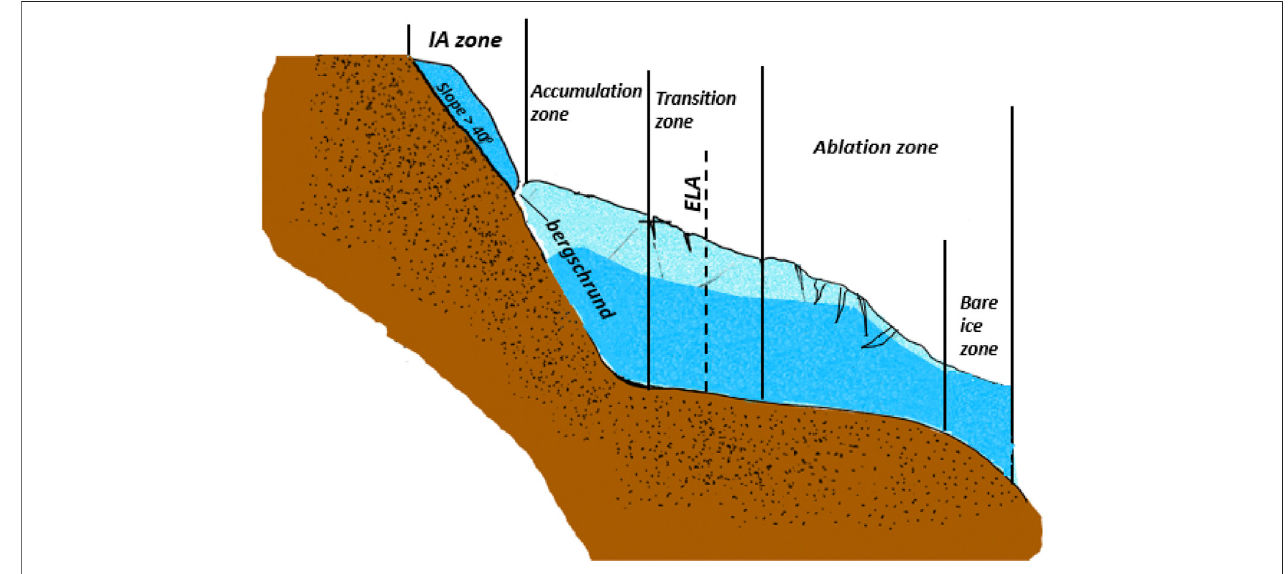
FIGURE 1 | Glacier zones. Brown: bedrock, dark blue: ice, light blue: